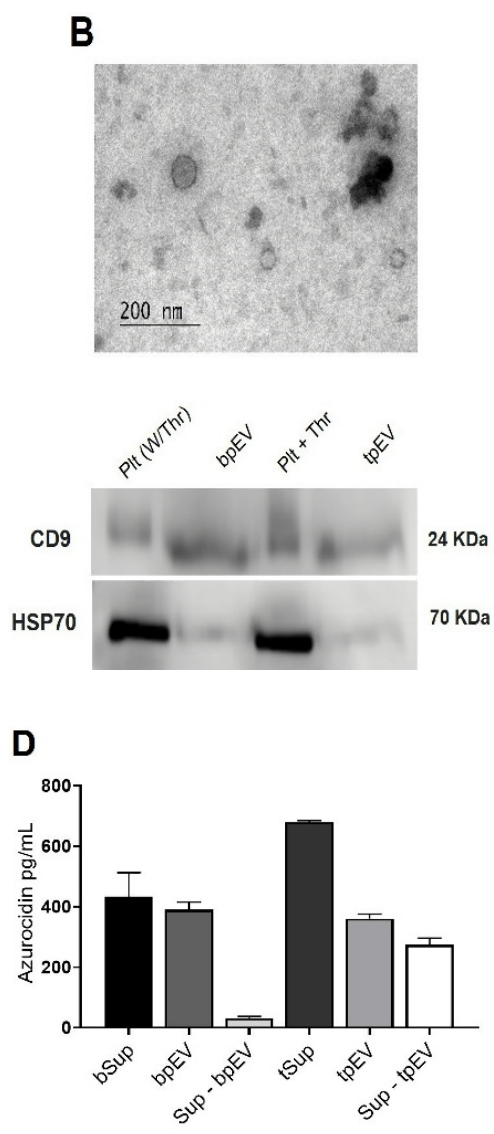
Figure 3. Platelets secrete azurocidin free and within EVs. ( A ) Stimulated 1 × 10 7 peripheral blood platelets (top) and 1 × 10 6 Meg-01 cells (bottom) with 1 U thrombin, 5 µM ADP, 1µg LPS, or 0.25